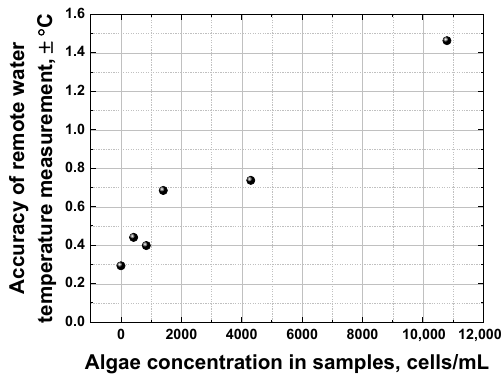
Figure 14. Dependence of the remote water temperature measurement accuracy on algae concen- tration in samples. Figure 14 clearly indicates that the accuracy of remote water temperature meas- urements changes almost linearly as a function of algal concentration. However, at ~11